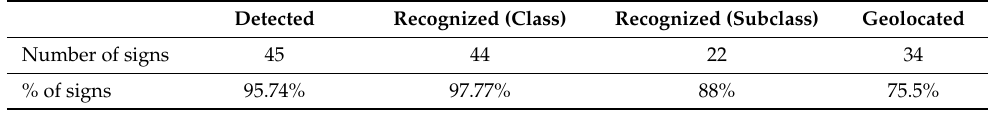
Table 7. Validation for the detection, recognition, and geolocation of traffic